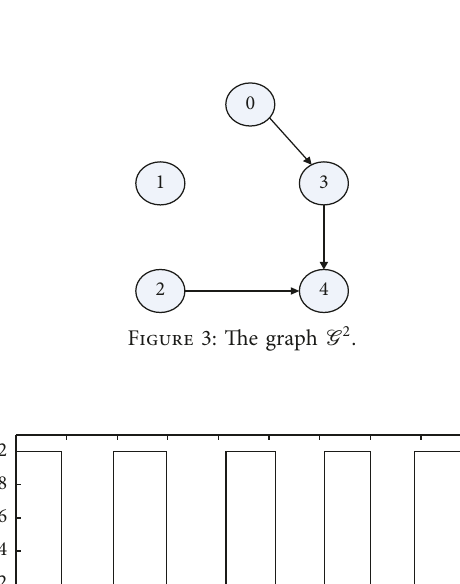
Figure 2: The graph G 1 .